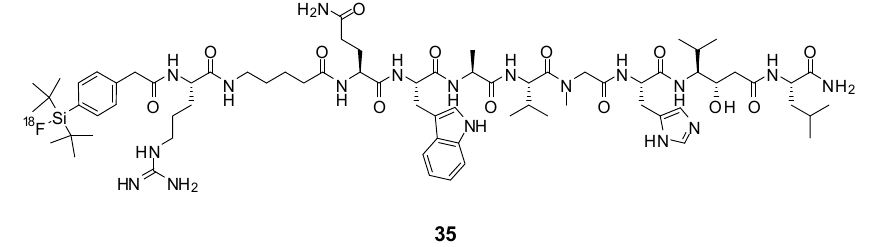
Figure 11. Structure of the 18 F-silyl-bombesin derivative 35 used for in